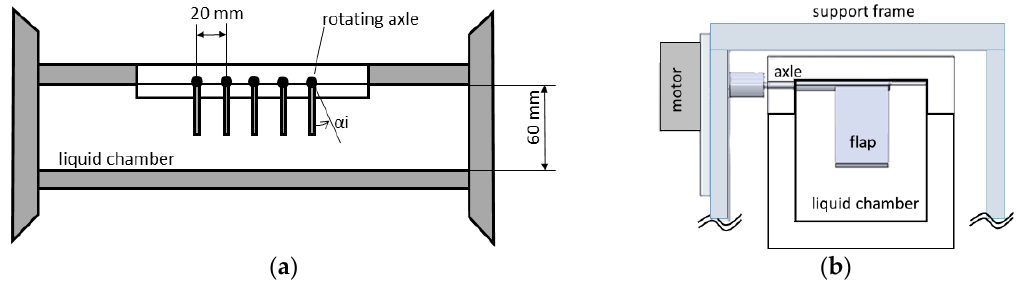
Figure 1. Schematic view of the closed working chamber: ( a ) front view of the chamber with the five flexible flaps at resting conditions and ( b ) side view of one flap clamped on the short side to the axle of one of the five motors.